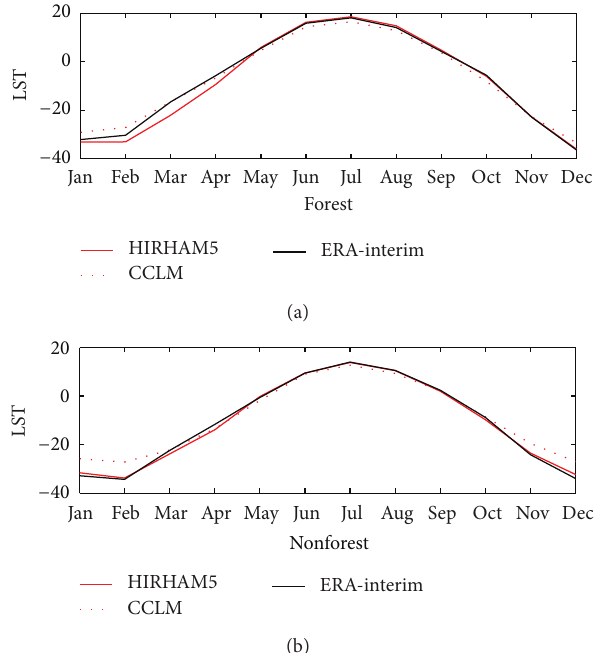
Figure 12: Annual cycle of land surface temperature (LST; ∘ C) for Siberian subdomain derived from HIRHAM5, CCLM and ERA-interim for forest (a) and nonforest (b) areas averaged over 2008 to